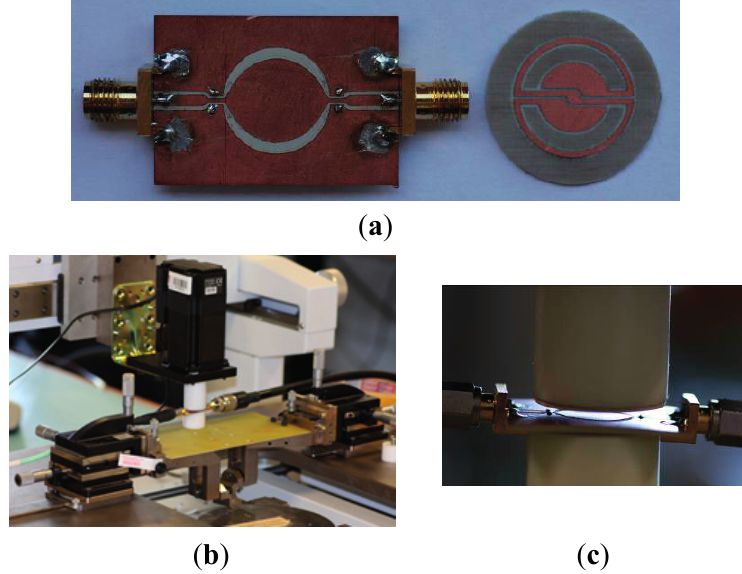
Figure 14. The fabricated prototype ( a ) and experimental set-up ( b ), including details ( c ), for the characterization of the rotation sensor with an STM 23Q-3AN step motor. The parameters of the Teflon cylinder adhered to the step motor are: h = 3.5 cm, ε r = 2.08 and tan δ = 0.0004.